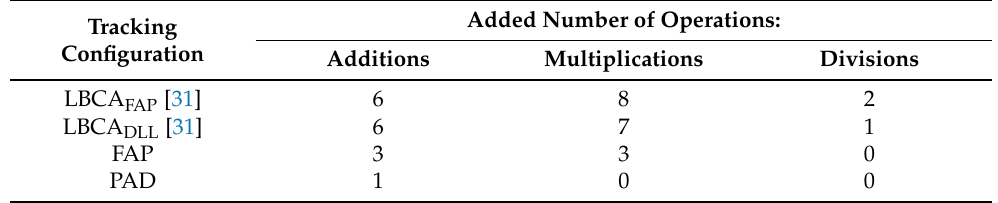
Table 3. Complexity of tracking configurations based on the added number of